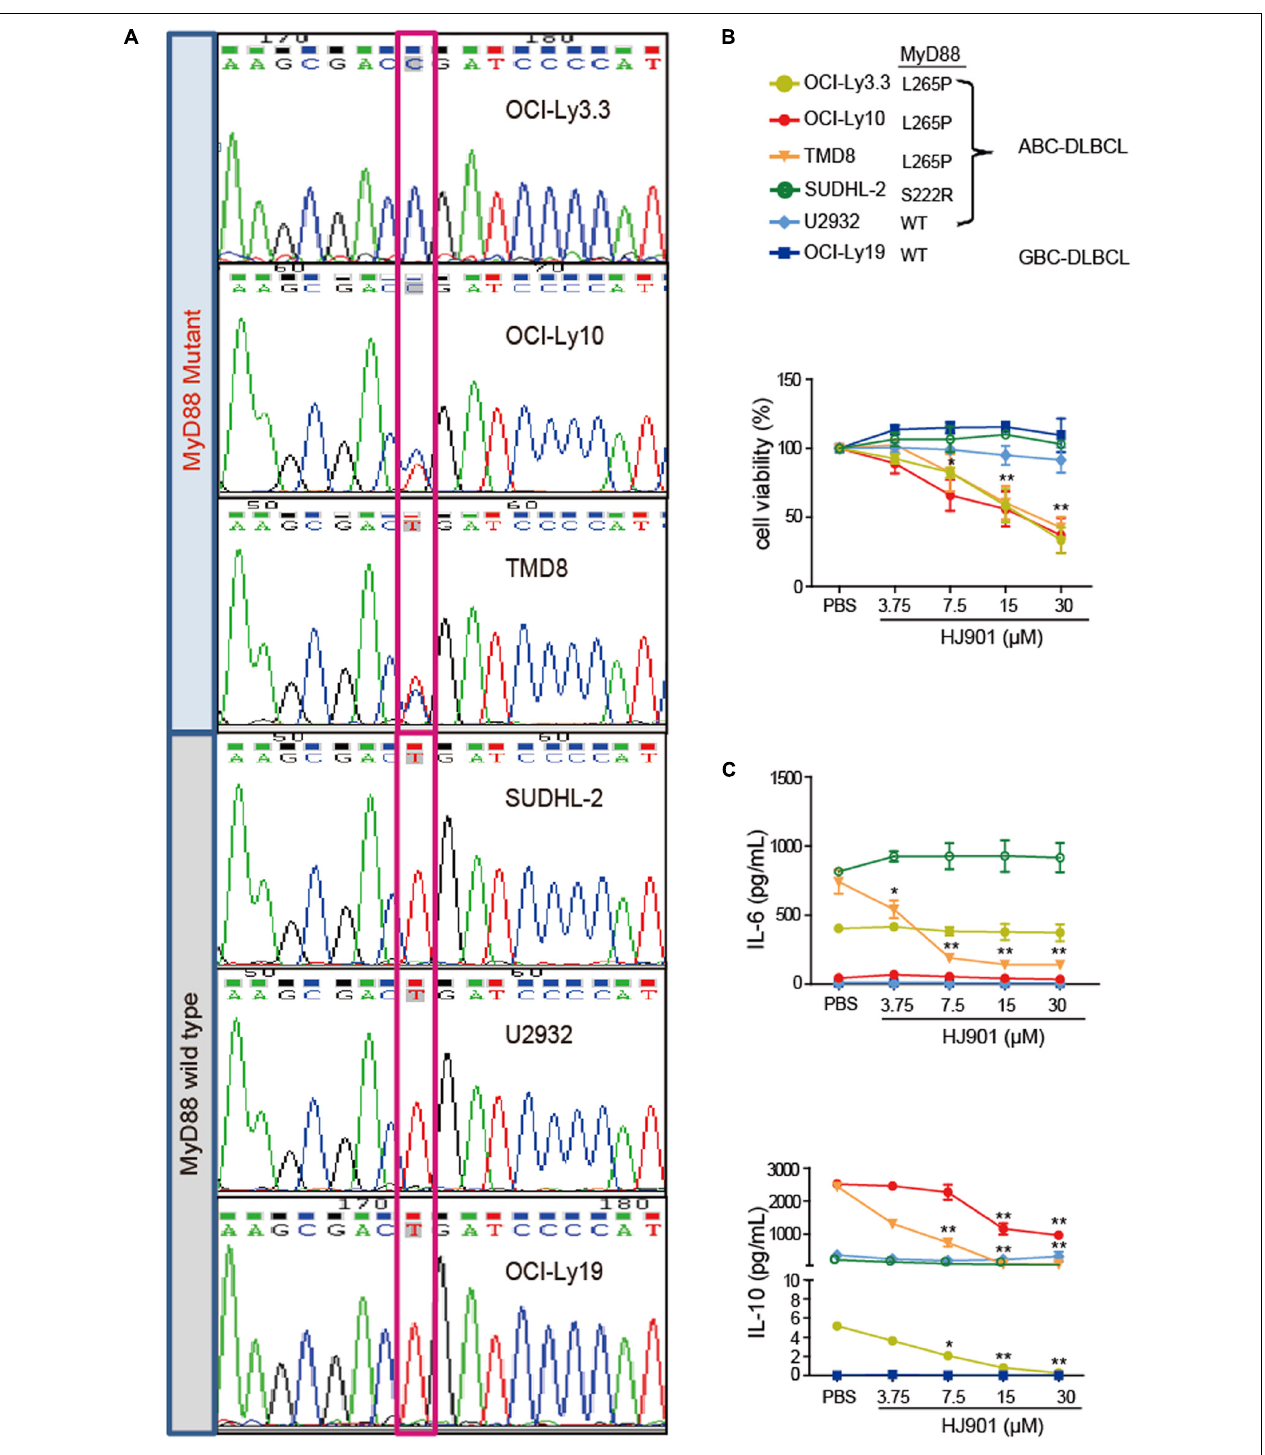
FIGURE 3 | Inhibitory effect of HJ901 on cell proliferation and cytokine secretion in vitro . (A) Confirmation of MyD88 mutation by Sanger sequencing in cell lines. The position of the MYD88 L265P locus is indicated by black frame. (B) Cells were plated in 96-well plates and treated with or without HJ901 for 72 h. The cell proliferation percentage was determined by the WST-1 assay. (C) Cells were incubated in the presence or absence of HJ901 concentrations for 36 h. Cell supernatants were assessed for IL-6 and IL-10 levels by CBA. All data are presented as the means ± SEM ( n = 5 in each group). * p < 0.05 and ** p < 0.01 vs. PBS